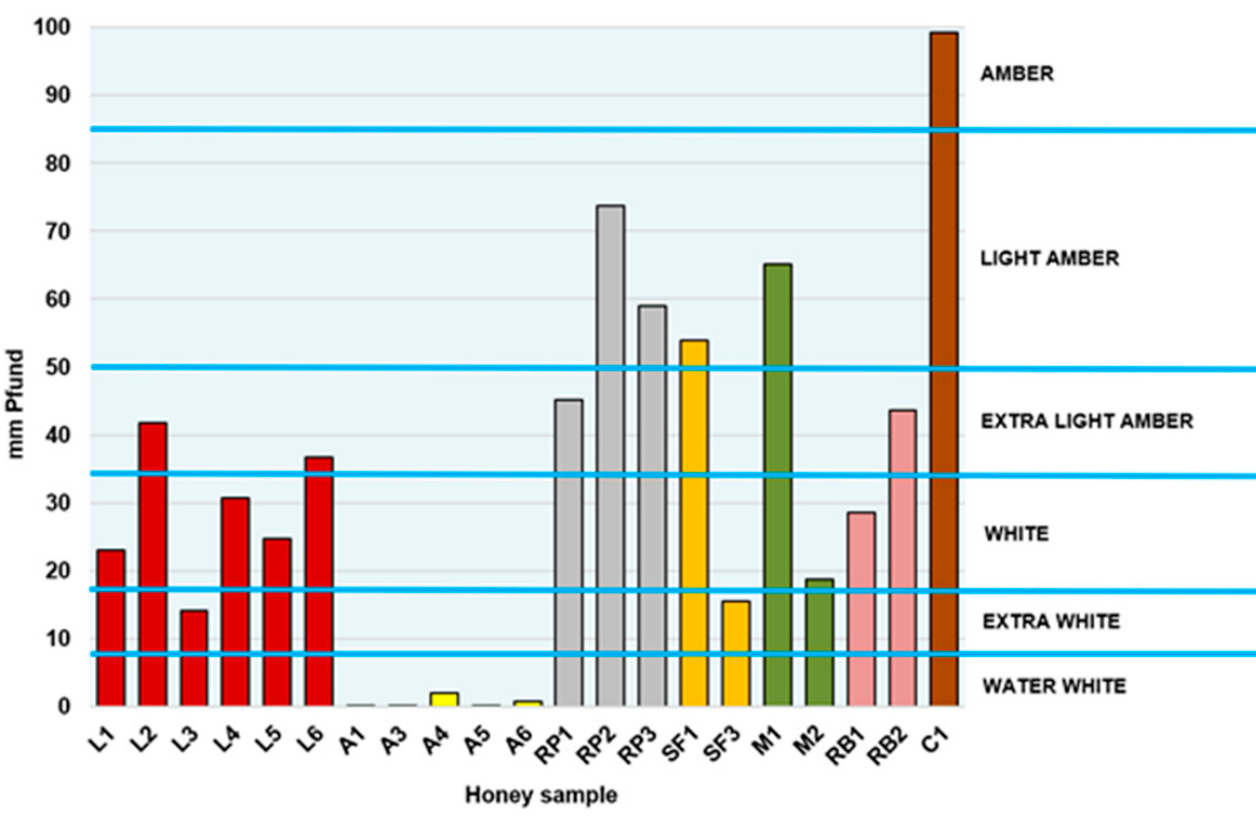
Figure 2. The color of the honey samples according to the Pfund scale. Table 2. Parameter values (mm Pfund, refractive index, moisture, solid substances’ content, and specific gravity) of seven types of In Table 2, the values of mm Pfund, refractive index, moisture, solid substances’ con- tent, and specific gravity are presented.